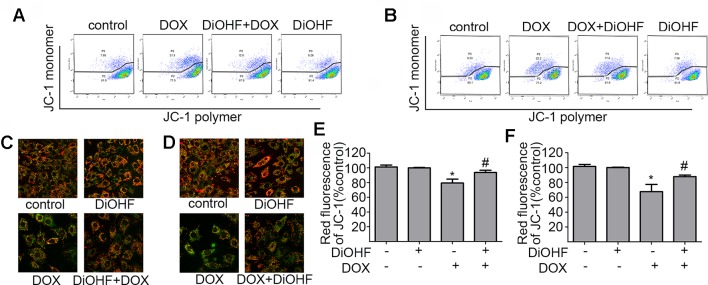
DiOHF prevented and rescued the DOX-induced mitochondrial dysfunction in H9C2 cells (A and B). Effects of pre- and post-treatment of DiOHF (10 μM) on the loss of MMP in H9C2 cells treated with DOX (1 μM for 24 h; n = 3). JC-1 was observed as green monomers in the cytosol or as red aggregates in intact mitochondria. The change from red to green fluorescence indicated a collapse of mitochondria with intact membrane potential. The micrographs were recorded under confocal microscopy (Zeiss) at 40× magnification (C and D; n = 3), and the red JC-1 fluorescence intensity was quantified (E and F) by Image Pro Plus. *P < 0.05, compared with control. #P < 0.05, compared with DOX.